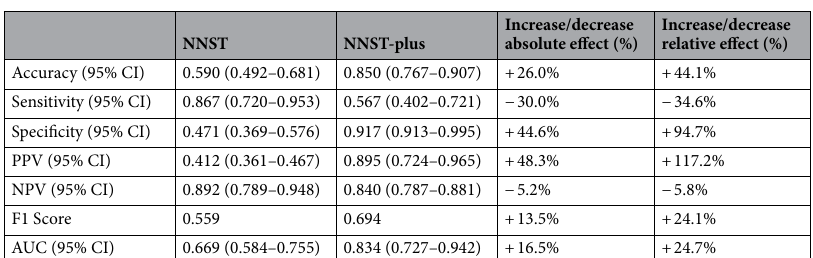
Table 3. Comparison of classification performances of NNST and NNST-plus.